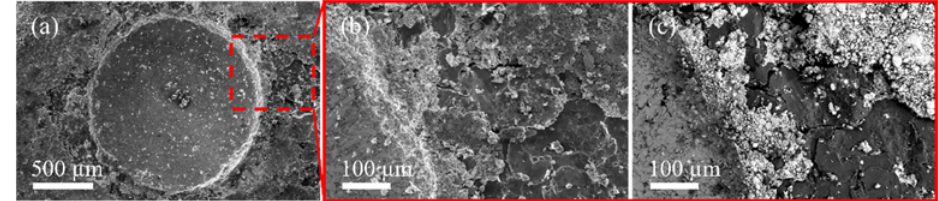
Figure 4. ( a ) SE ‐ SEM micrograph of the indentation print on coated nanocomposite. Zoom ‐ in view Figure 4. ( a ) SE-SEM micrograph of the indentation print on coated nanocomposite. Zoom-in view of of the delamination of the material around the trace of the Zn coating in ( b ) SE ‐ SEM and ( c ) BSE ‐ SEM images.